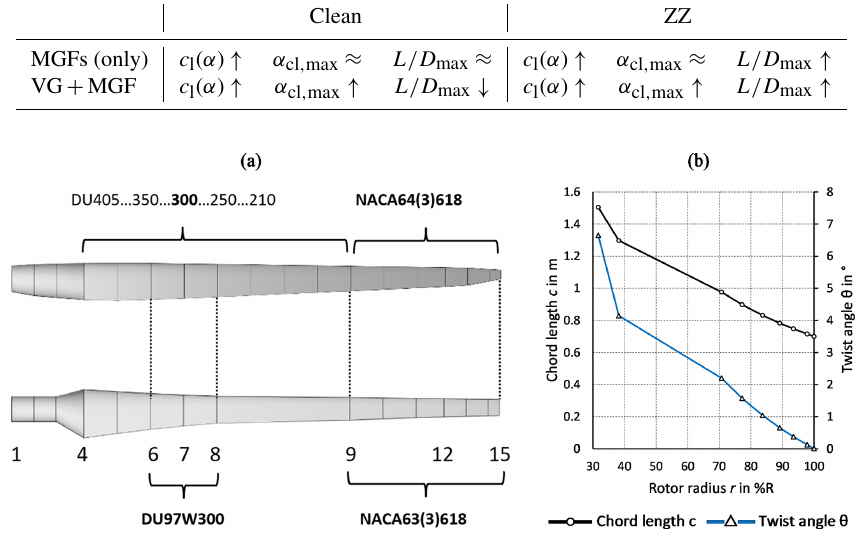
Figure 13. (a) Design of the generic rotor blade based on the NREL 5MW reference wind turbine. (b) Geometry of the generic blade over the rotor